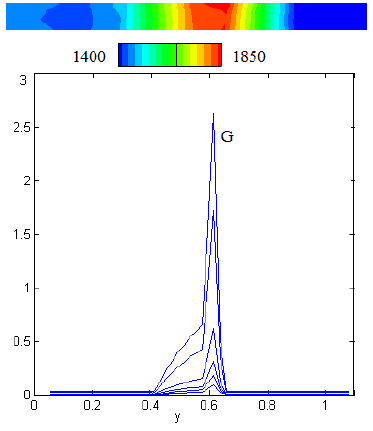
Figure 10. Incident radiation and volumetric contribution of thermal radiation (W/m 3